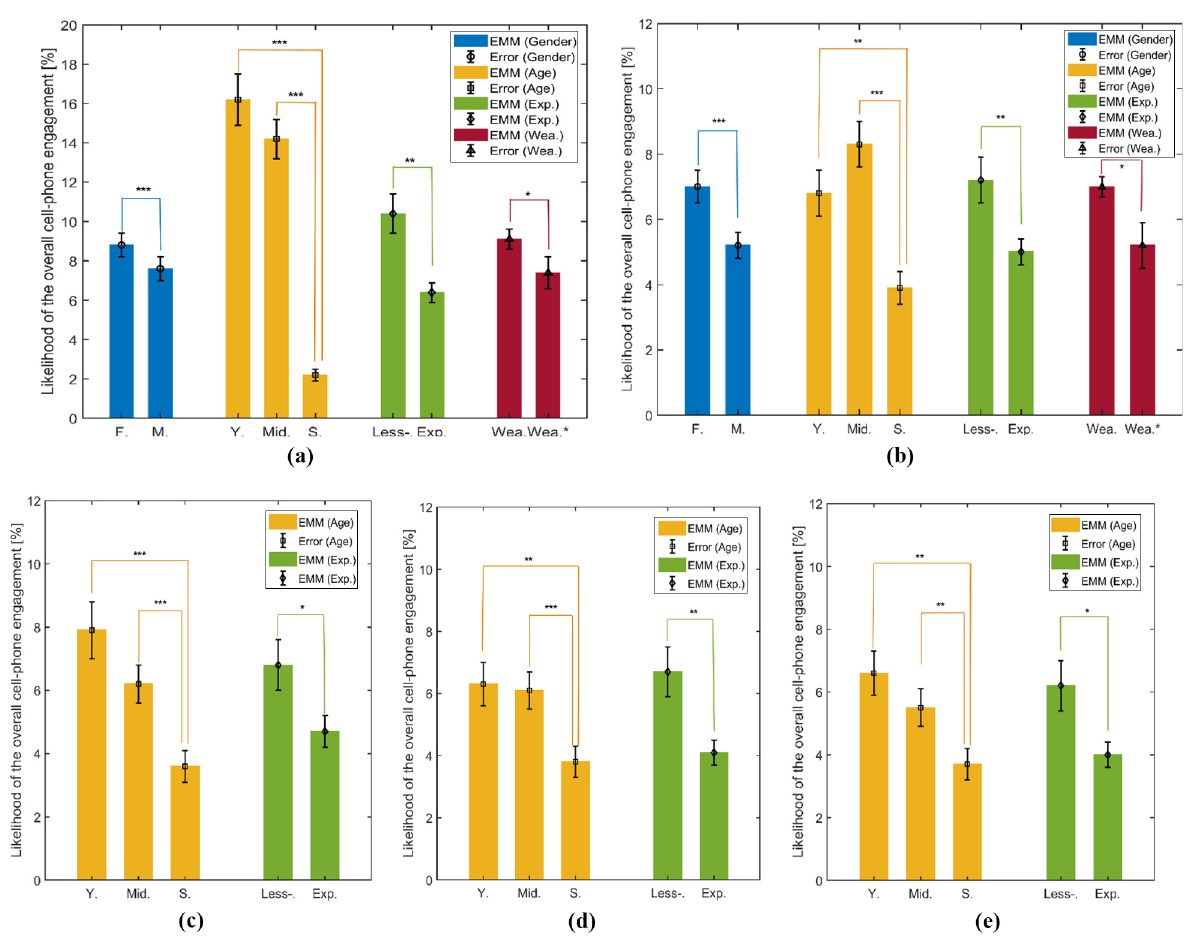
Figure 5 EMM of the likelihood of the cell phone engagement (F.: female, M.: male, Y.: young, Mid.: middle-aged, S.: senior, Less-: less-experienced, Exp.: experienced, Wea.: weather. Wea. (cid:5) represents adverse weather conditions were recorded. EMM: Estimated Marginal Mean. Signi fi cance level: (cid:5)(cid:5)(cid:5) P < 0.001, (cid:5)(cid:5) P < 0.01, (cid:5) P <